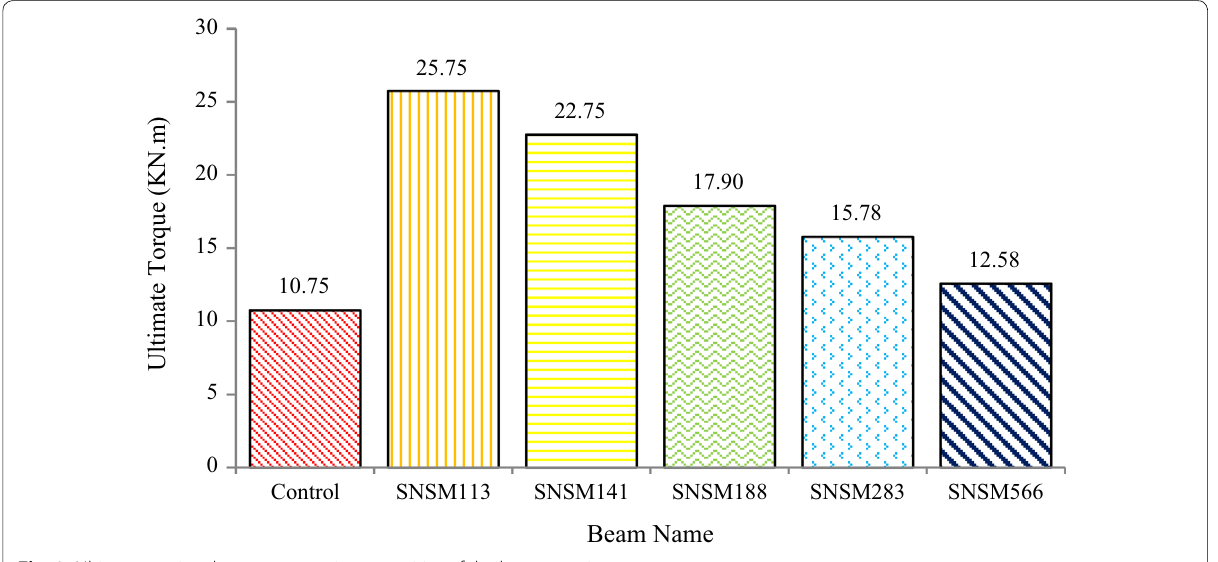
Fig. 8 Ultimate torsional moment carrying capacities of the beam